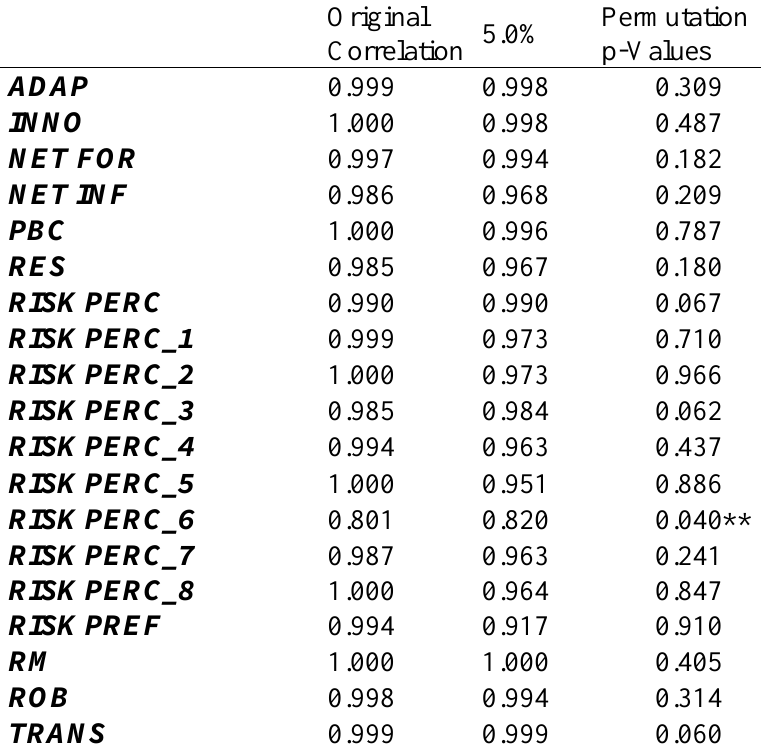
Original 5.0% Correlation